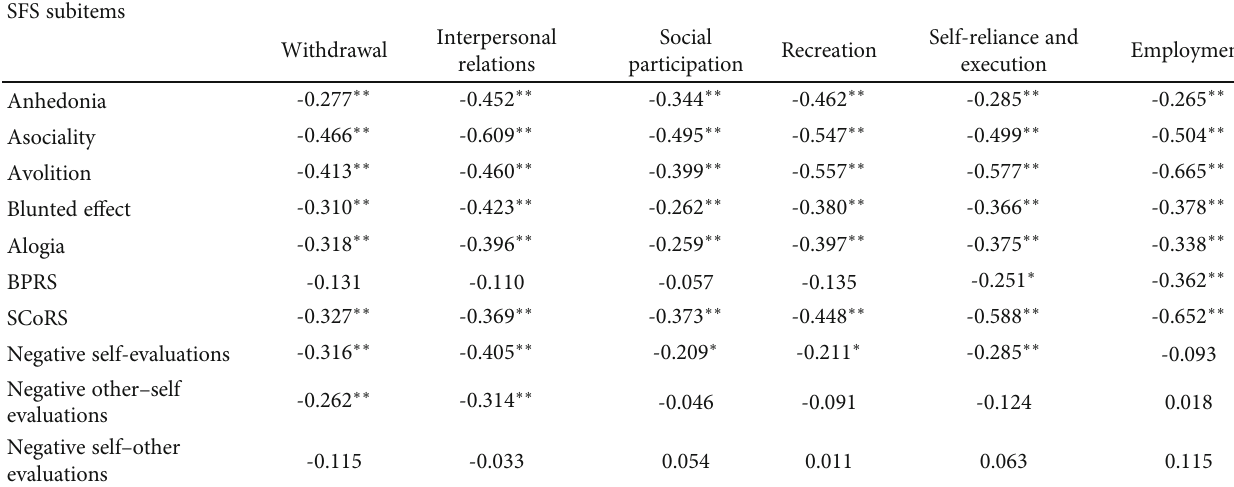
Table 2: Correlations between SFS subitems and symptoms (R).